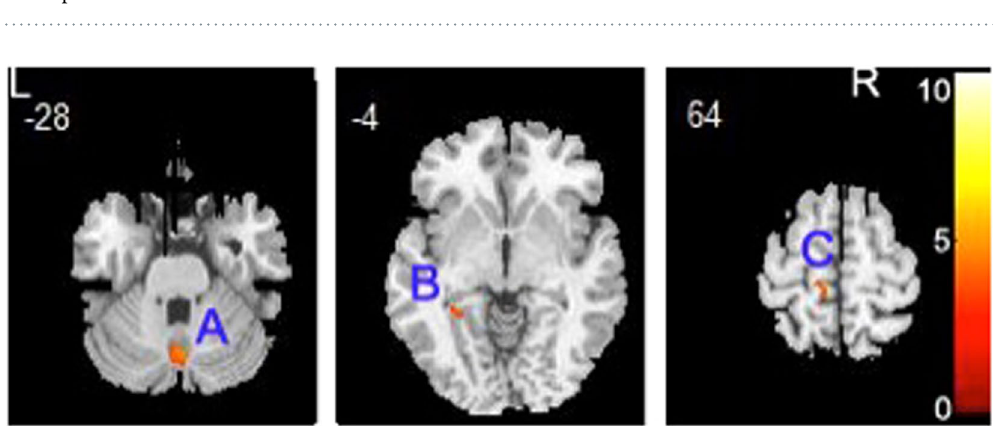
Table 3. Decreased gray matter volume in patients with adolescent-onset, drug-naive first-episode